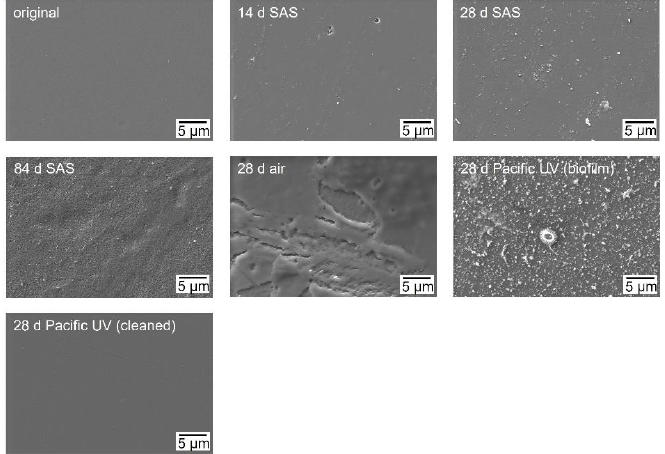
Figure 7. Yellowness index illustrating the degree of yellowness of the lab-weathered samples (14, 28, and 84 days in SAS and 28 days in air) and of the 28-day naturally weathered samples with and without UV irradiation after cleaning in comparison with a non-weathered original PET sheet.